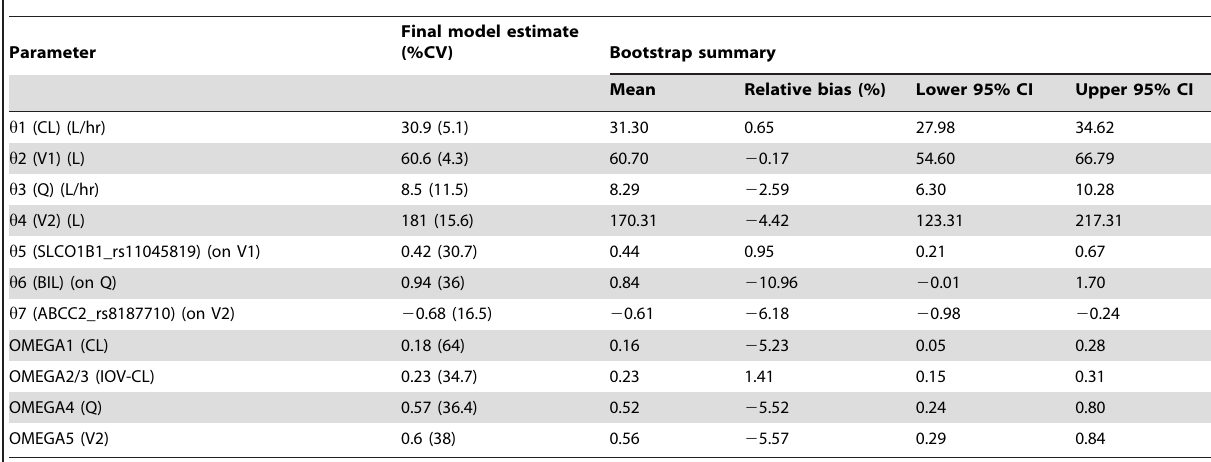
Table 8. Population estimates from final model and bootstrap analysis.